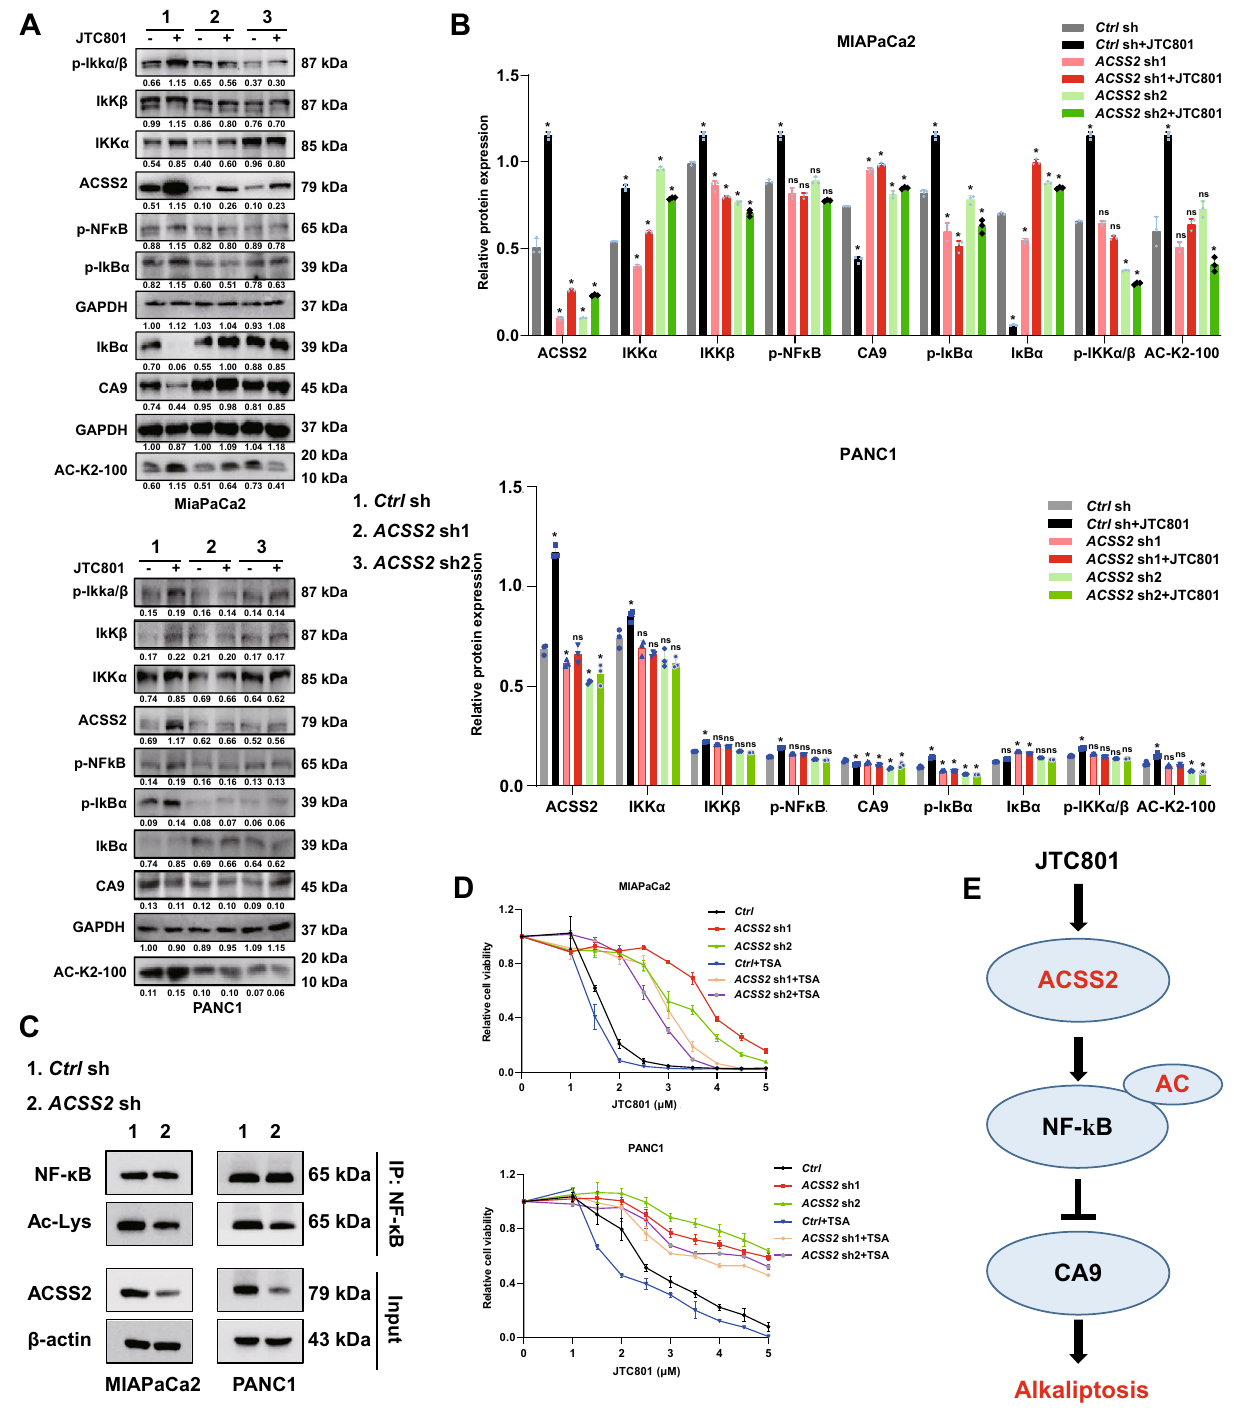
Figure 4. ACSS2-mediated histone acetylation promotes alkaliptosis. ( A , B ) Western blot analysis of indicated protein expression in control or ACSS2 knockdown cell lines following treatment with JTC801 (3 μM) for 24 h (n = 3 biologically independent samples). Representative western blot results are shown in the left panel. The membrane were cropped and probed for indicated antibodies. The membrane of p-IKKα/β was stripped and reprobed for IKKα and IKKβ. The membrane was incubated in reblot solution for 30 min and blocked for 30 min at room temperature with TBST-containing skin milk (5%) and probed overnight at 4 °C with anti- IKKα. Repeat the above steps to reprobed the membrane with the anti-IKKβ antibody. The membrane of p-NFκB was stripped and reprobed for ACSS2. The membrane of p-IκBα was stripped and reprobed for IκBα and GAPDH. The protein expression of CA9 were measured in indicated cell lines following treatment with JTC801 (3 μM) for 24 h under 5%CO 2 and normoxia. Quantitative results are plotted in the right panel. ( C ) Control or ACSS2 knockdown in MIAPaCa2 and PANC1 cells. Cell lysates were extracted for coIP, the immunoprecipitates were analyzed using the indicated antibodies and representative western blot shown in the left panel. The membrane of Ac-lys was stripped and reprobed for NFκB. ( D ) Control or ACSS2 knockdown cell lines were treated with JTC801 (1–5 μM) in the absence or presence of trichostatin (TSA, 200 nM) for 24 h and then the cell viability was assayed (n = 3 biologically independent samples). ( E ) Schematic diagram of the role of ACSS2 in JTC801-induced